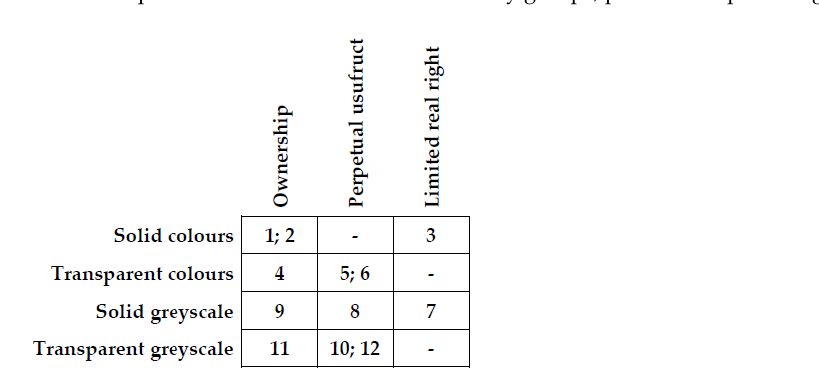
Figure 9. The percentage of correct answers depending on the visualization parameters used to show the specific right assigned to the property (based on rules provided in Figure 8).